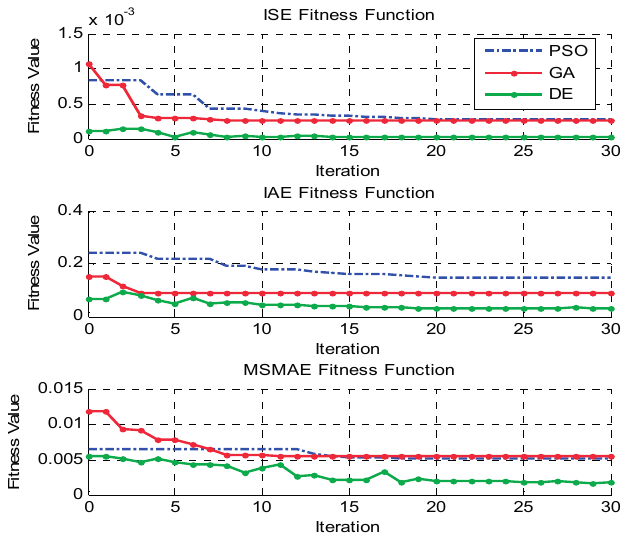
Figure 3. Fitness function best values for nonlinear